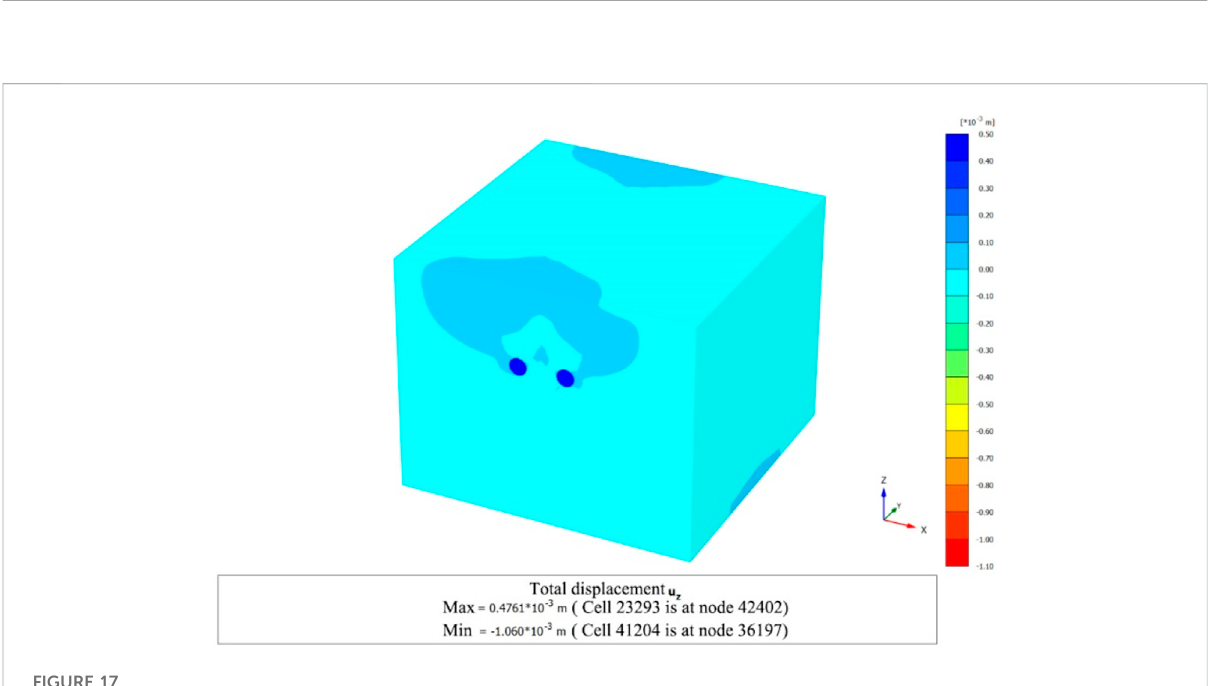
FIGURE 17 Vertical displacement nephogram of the soil in connecting aisle No.11.